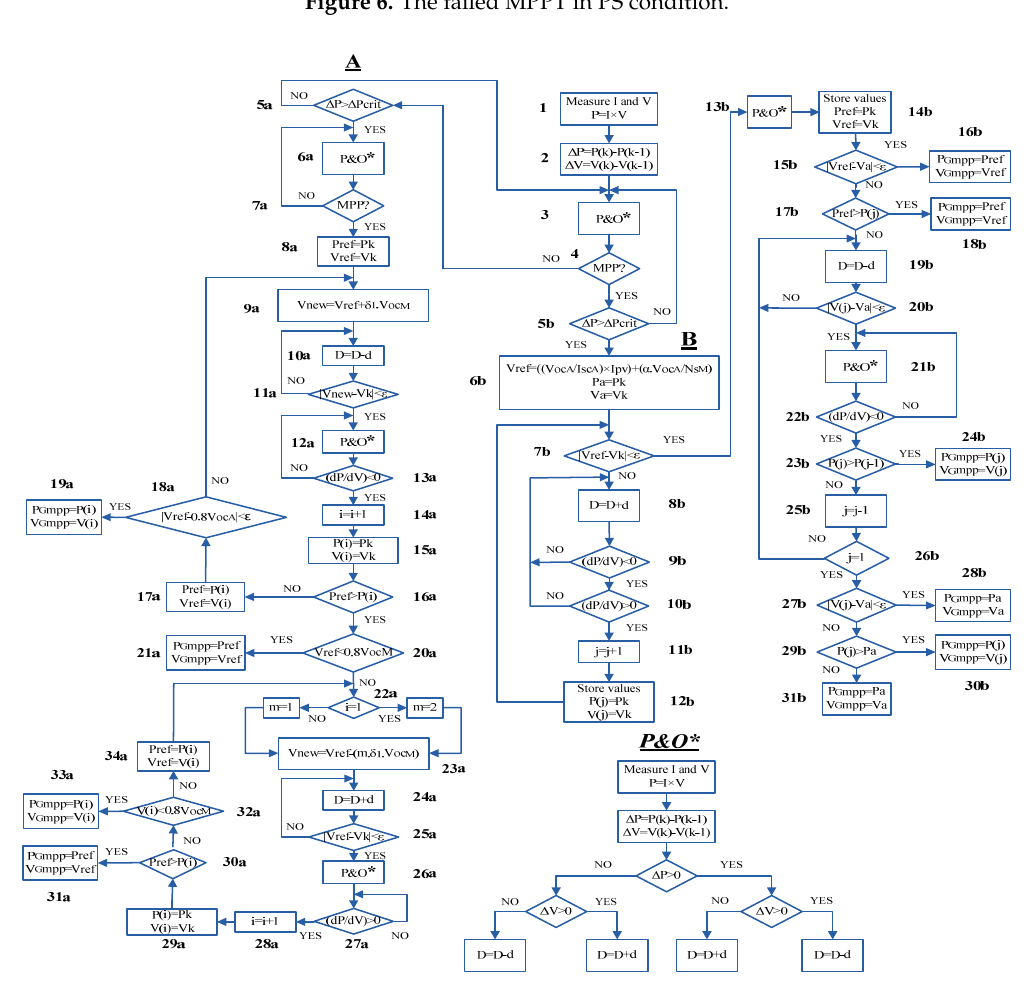
Figure 7. The flowchart of the proposed method.